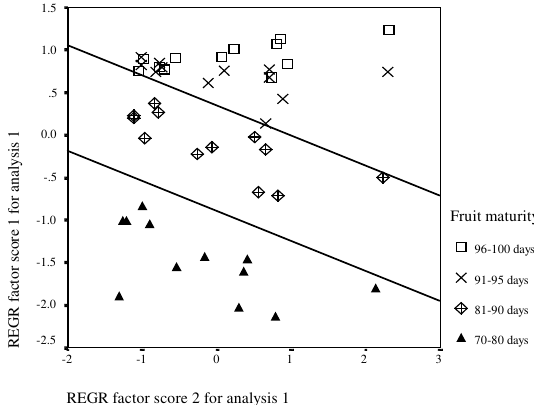
Fig.4. Discriminating abilities of the jackfruit classified according to stages